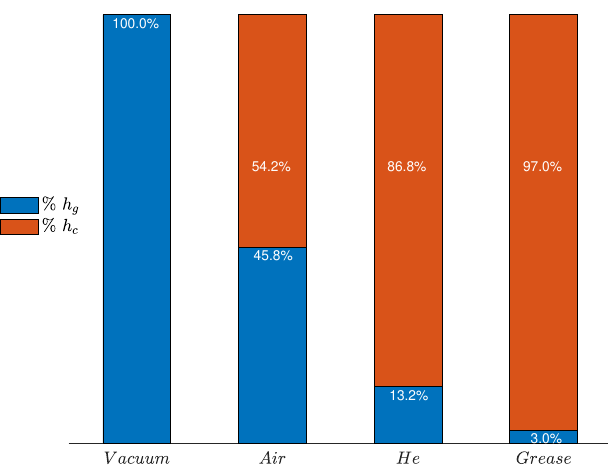
Figure 14. Thermal contact resistance distribution comparison at the nodes located at the diagonal of the contact zone.